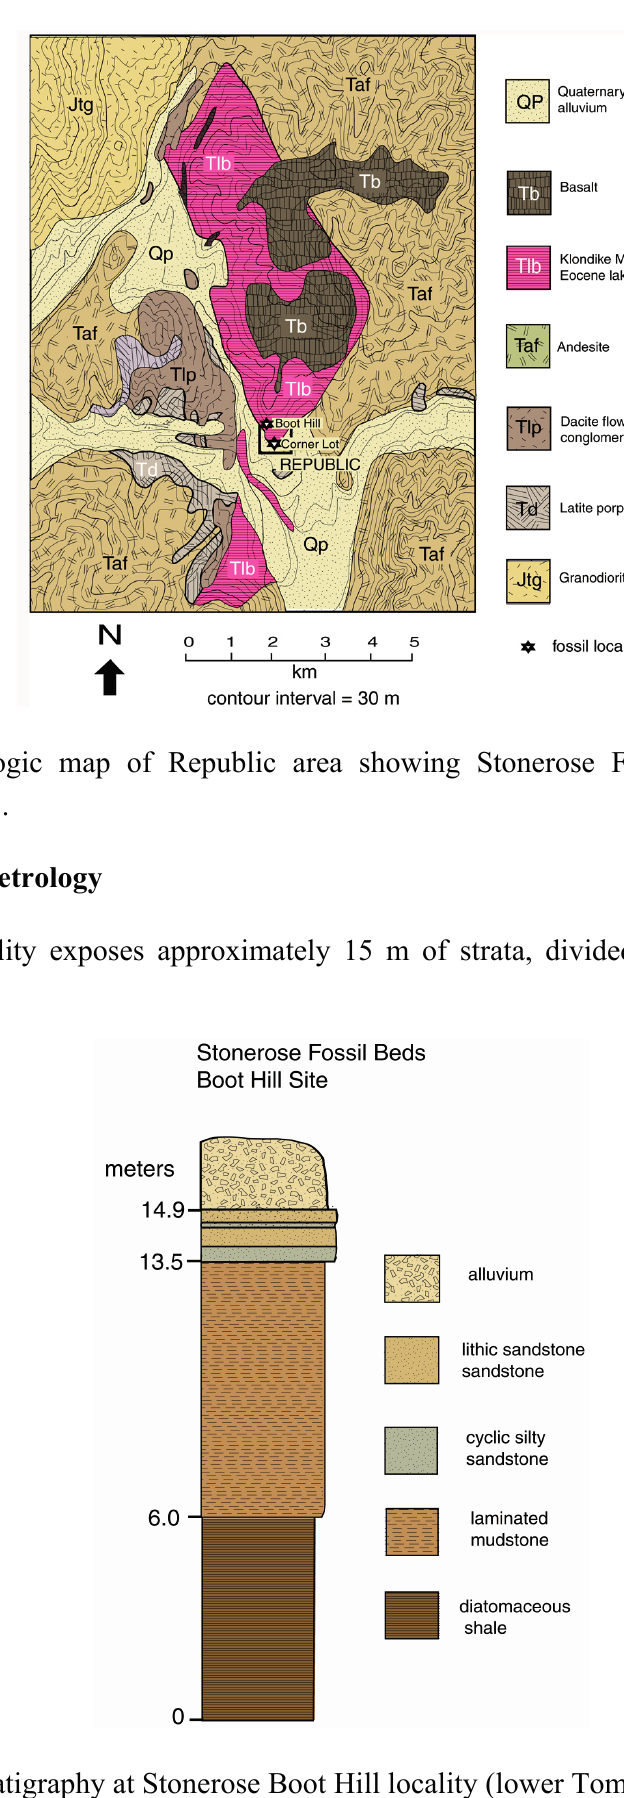
Figure 4. Stratigraphy at Stonerose Boot Hill locality (lower Tom Thumb